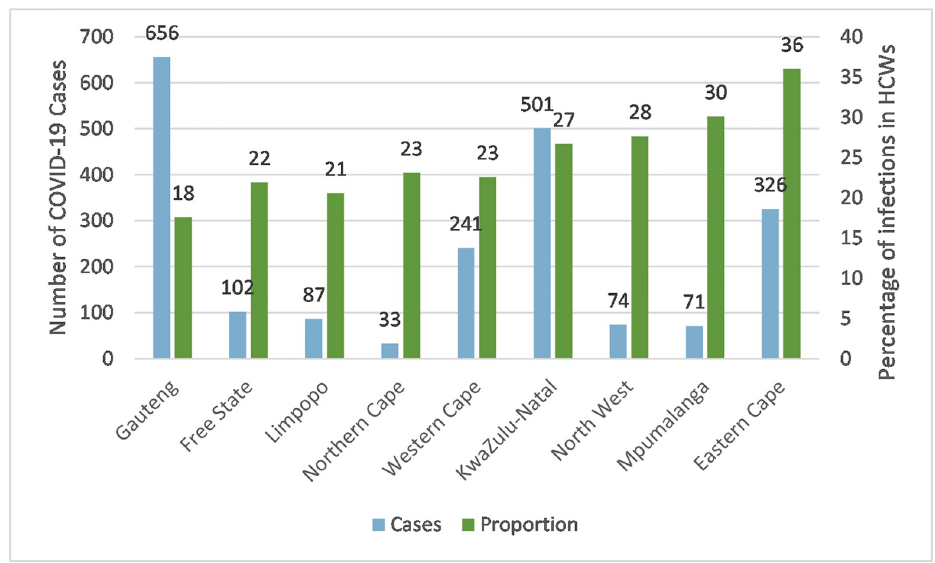
Fig 3. Proportion of COVID-19 positive cases among medical laboratory services staff by province, 1 April 2020– 31 March 2021. (chi-square p < 0 . 001 ).